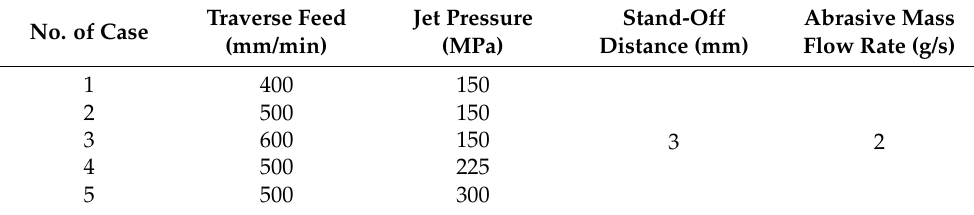
Table 2. Experimental parameters.